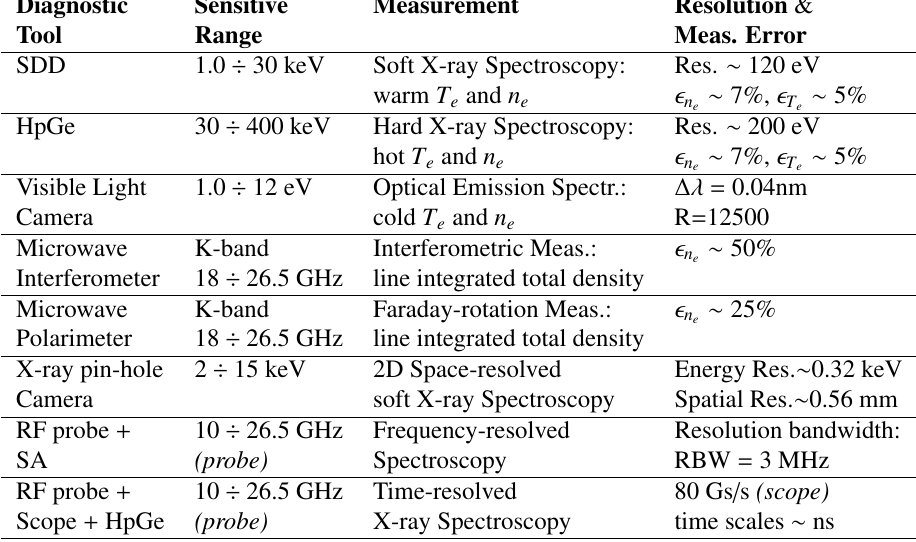
Table 1. Lists of the non invasive tools, with their most relevant characteristics, being part of the multi-diagnostic